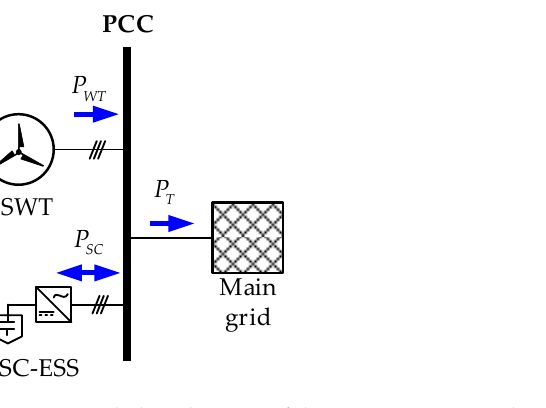
Figure 3. Single-line diagram of the power system under study.